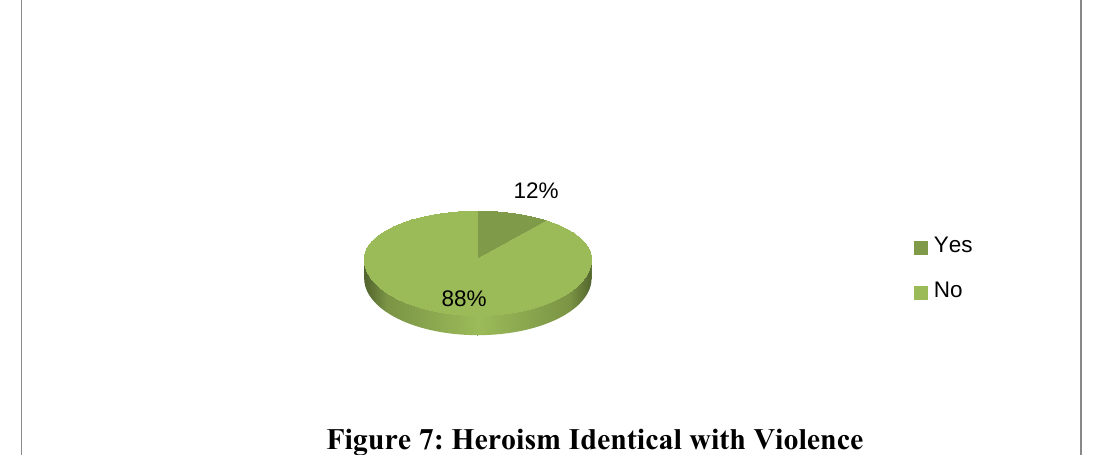
Figure 7: Heroism Identical with